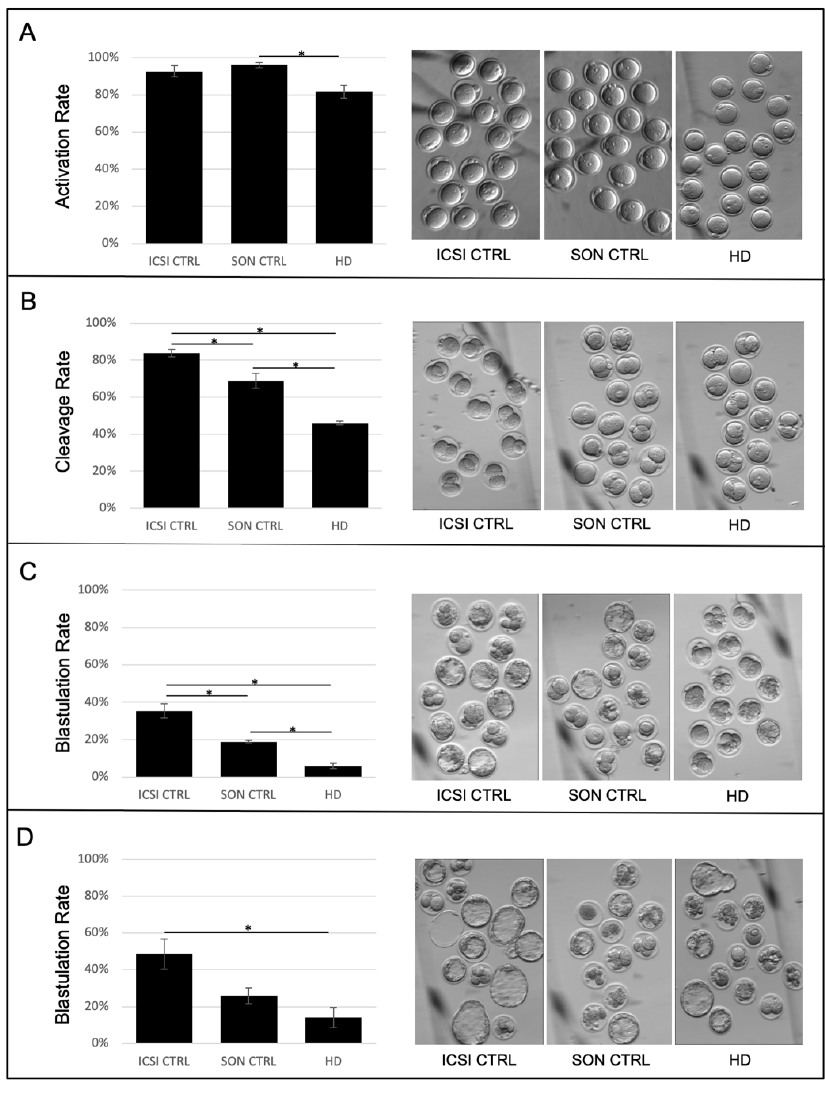
Figure 9. Mouse embryo development of ICSI-injected oocytes fertilized with PT-histone-deficient spermatozoa: ( A ) Oocytes injected with PT histone deficient (HD) spermatozoa activate at a rate comparable to controls. The number of activated oocytes in each experimental group was counted at 6 h post-ICSI and four replicates were performed per experimental group. The activation rate of HD oocytes (81.7%, n = 91) was significantly lower than that of SON CTRLs (96.0%, n = 95), but not significantly different from ICSI CTRLs (92.6%, n = 81). ( B ) HD zygotes cleave at a lower rate than controls. The number of cleaved embryos in each experimental group was counted at 22–24 h post-ICSI and four replicates were performed per experimental group. The cleavage rate of HD zygotes (46.0%, n = 91) was significantly lower than that of ICSI CTRL (83.8%, n = 81) and SON CTRL (68.9%, n = 95) groups. Control groups also displayed significantly different rates. ( C ) HD embryos blastulate at lower rate than controls on day 4. The number of blastocysts in each experimental group was counted at 4 days post-ICSI and three replicates were performed. The blastulation rate of HD zygotes (6.0%, n = 58) was significantly lower than that of ICSI CTRL (35.3%, n = 62) and SON CTRL (18.9%, n = 69) groups. ( D ) HD embryo blastulation rates improve as development progresses. The number of blastocysts in each experimental group was counted at 5 days post-ICSI and three replicates were performed. The blastulation rate of HD zygotes (14.1%, n = 58) was significantly lower than that of ICSI CTRL (48.7%, n = 62) but not statistically different than SON CTRL (25.9%, n = 69). For all panels p values ≤ 0.05 are denoted by a star (*), error bars represent SEM and representative images of each group are